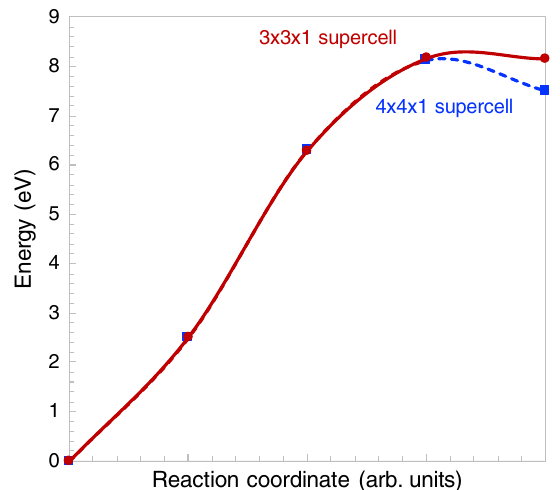
FIG. 15. Frenkel barrier dependence on supercell size for PdCoO 2